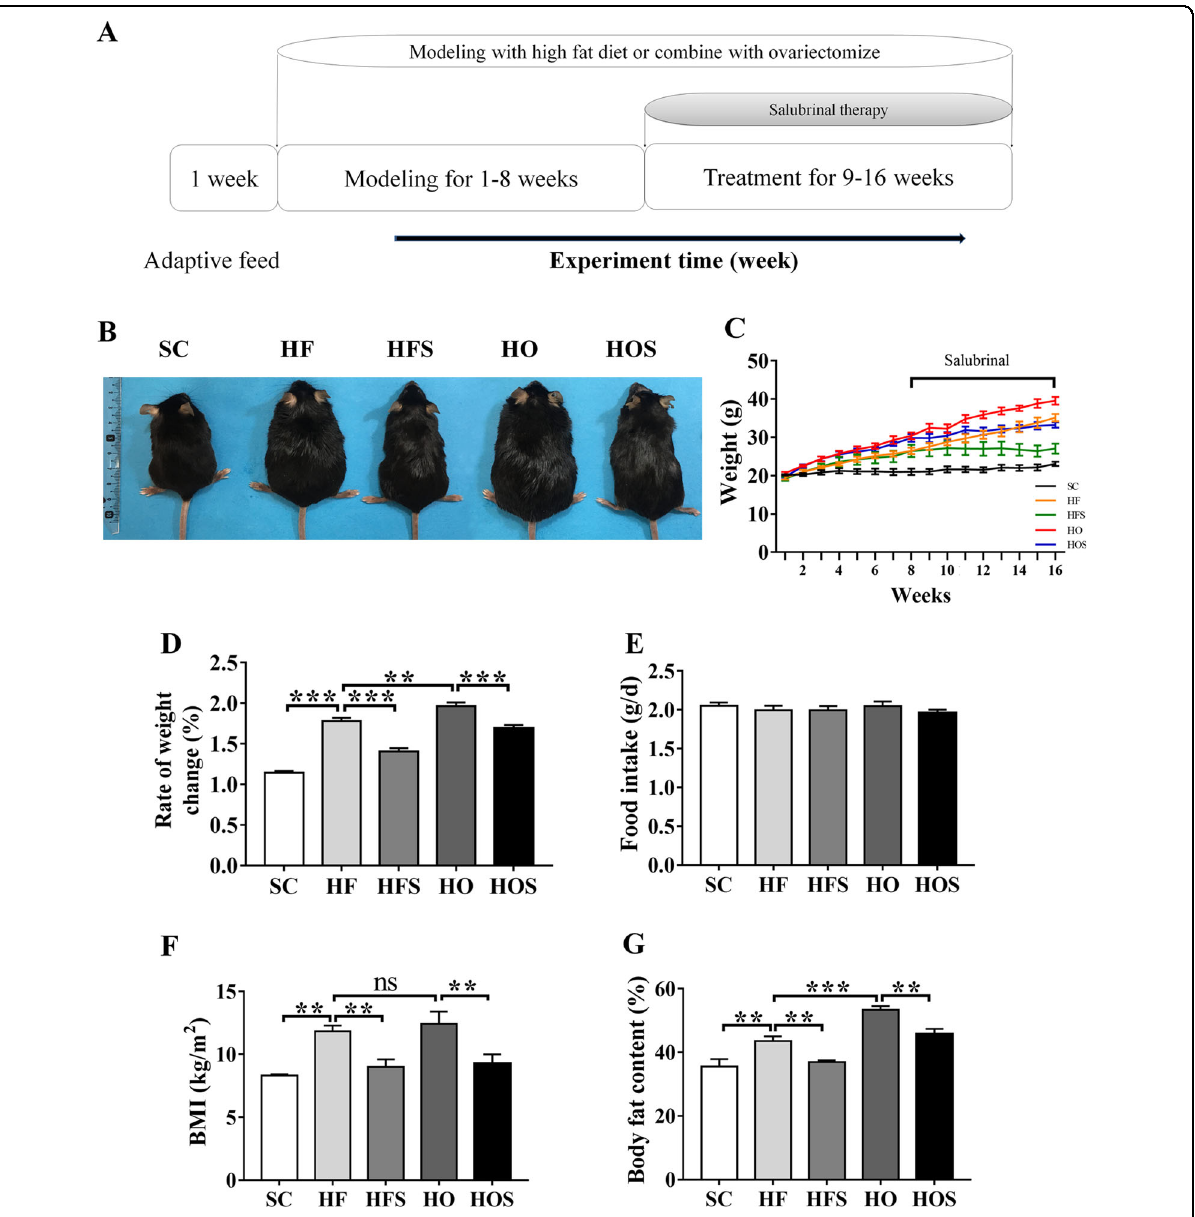
Fig. 1 Salubrinal attenuated obesity. a Experiment timeline. b Whole Body image. c Weight change. d Rate of weight change. e Daily food intake (per day among fi ve groups). f Body mass index (BMI). g Whole-body fat content. All values were reported as mean ± SEM ( n = 10/groups and images were taken randomly). The asterisks (*, **, and ***) represent P < 0.05, P < 0.01, and P < 0.001, respectively. N.s., not signi fi